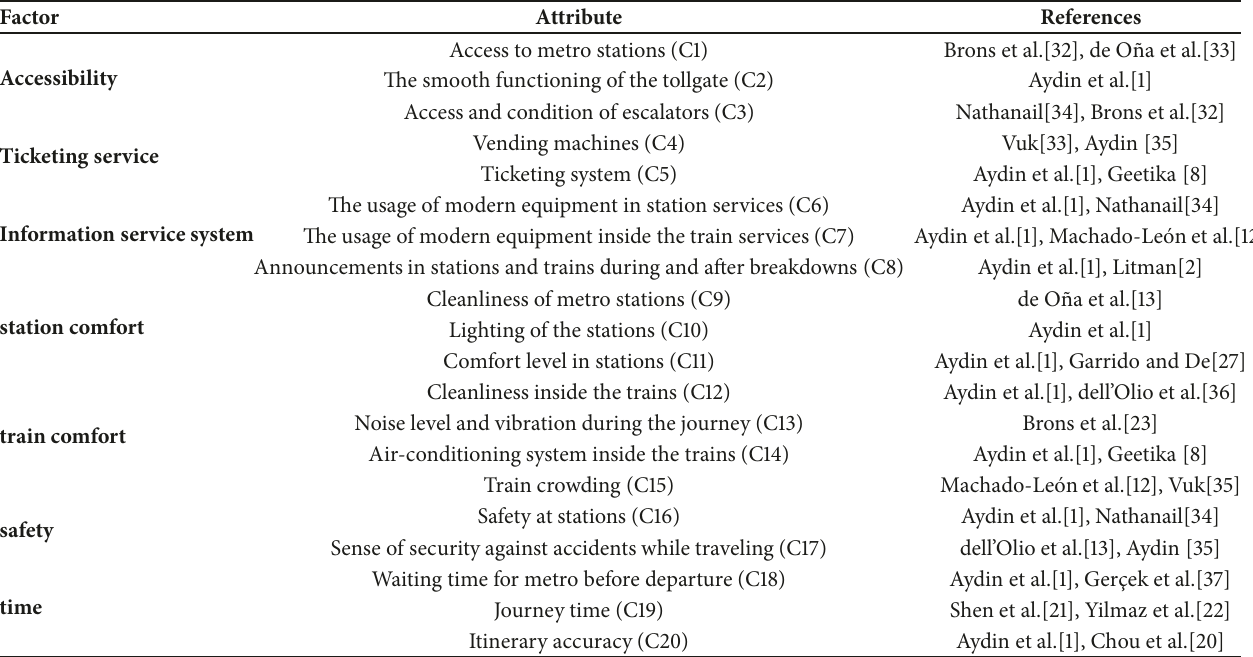
Table 1: Evaluation index for customer satisfaction of urban rail